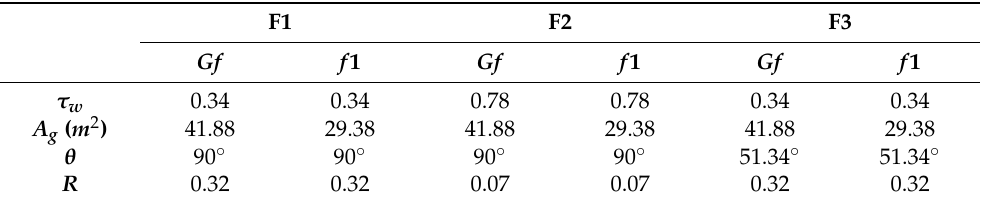
Table 8. The set fenestration design parameters for F1, F2, and F3.